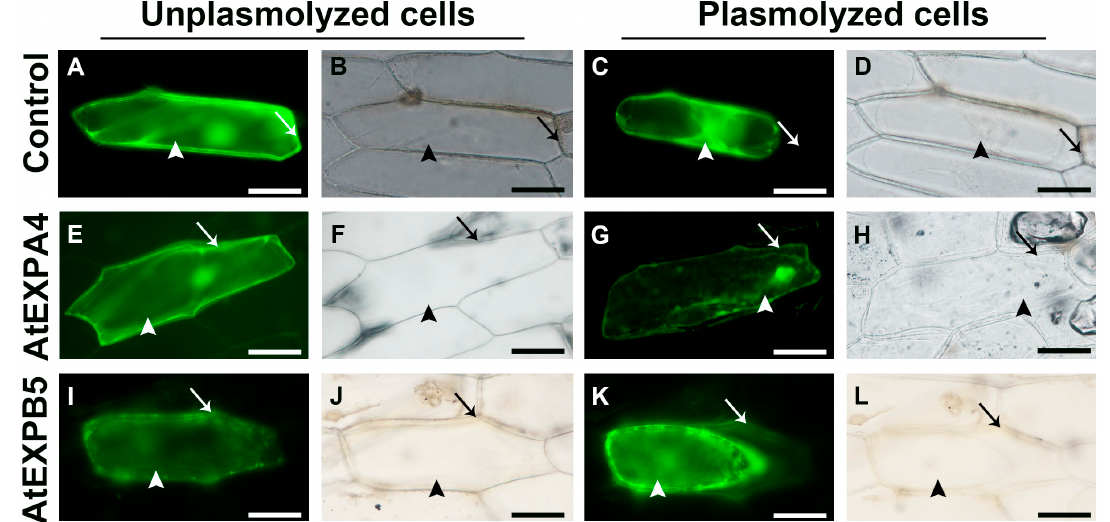
Figure 2. Subcellular localizations of AtEXPA4::eGFP and AtEXPB5::eGFP fusion proteins in onion epidermal cells. ( A – D ), Control cells with eGFP signals. ( E – H ), Onion epidermal cells with AtEXPA4::eGFP fusion signals. ( I – L ), Onion epidermal cells with AtEXPB5::eGFP fusion signals. ( A , C , E , G , I , K ), Fluorescence images. ( B , D , F , H , J , L ), Brightfield images. ( A , B , E , F , I , J ), Unplasmolysed cells. ( C , D , G , H , K , L ), Plasmolysed cells. Arrows and arrow heads indicate cell walls and cytoplasm, respectively. Scale bars, 100 μ m.